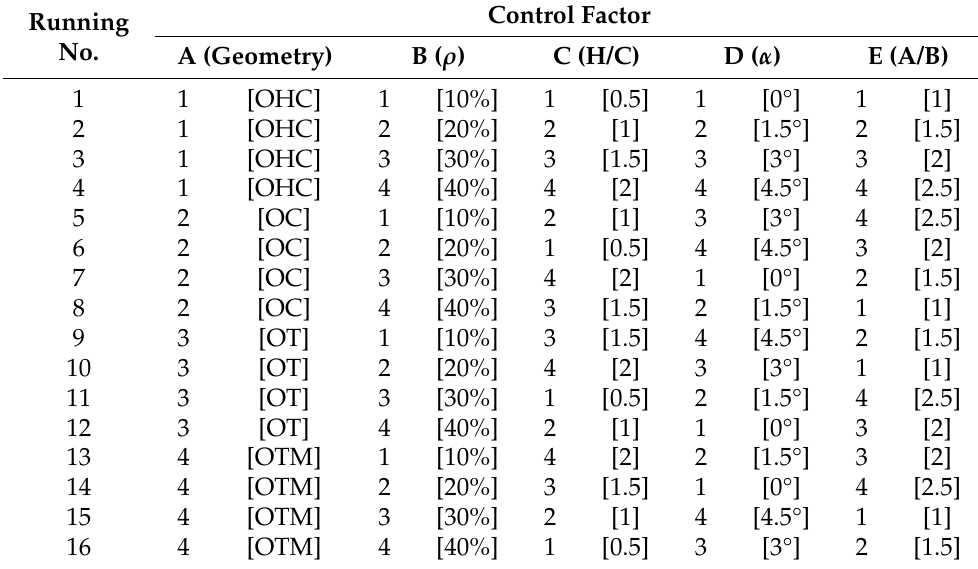
Table 2. Complete Taguchi’s Design of